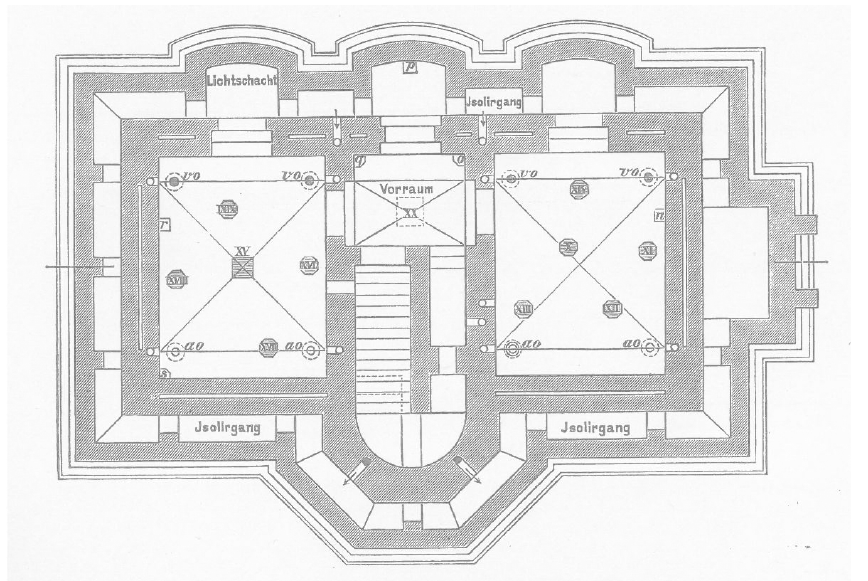
Figure 2. Ground plan of the observatory building basement. Source: Hellmann (1912).